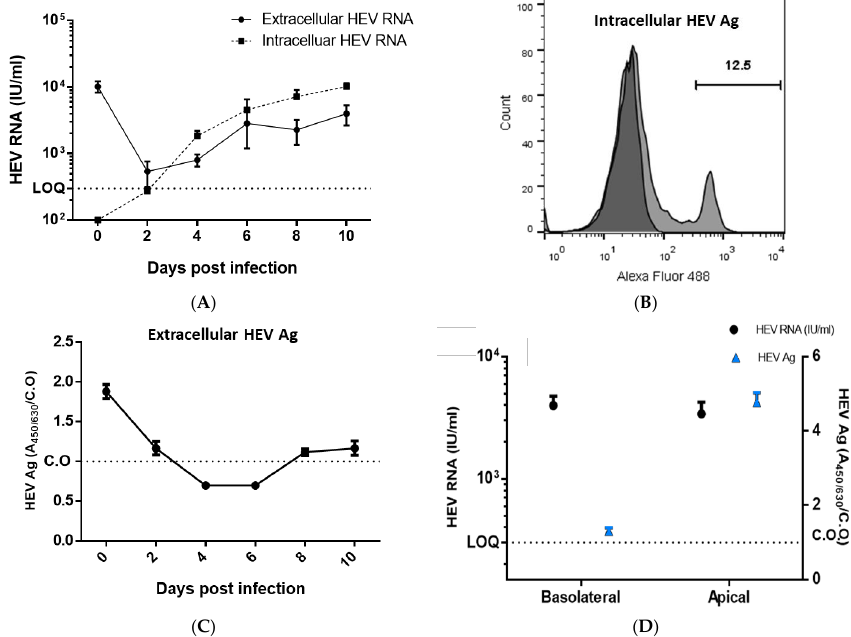
Figure 2. Infection of the CD10 + /CD13 + PT epithelial cells with HEV inoculum. ( A ) Infection of polarized CD10 + /CD13 + PT cells, cultured on transwell, with HEV-1 inoculum at the basolateral side. Intracellular (dotted line) and extracellular (solid line) HEV RNA was quantified by qPCR. LOQ: limit of quantification. Depicted are the mean values of three independent experiments ± SEM. ( B ) Representative gating strategy showing the expression of HEV ORF2 Ag in the PT cells infected with HEV. The dark histogram represents cells stained with the secondary A488 conjugated anti-mouse antibodies alone; the light shaded histogram represents cells stained by mouse anti-HEV-ORF2 followed by A488 conjugated anti-mouse antibody. ( C ) Supernatants collected from HEV-1 infected PT cells were tested for HEV ORF2 Ag by ELISA, C.O is the cutoff. Depicted are the mean values of three independent experiments ± SEM. ( D ) HEV RNA (black), and HEV Ag (blue) were measured at the basolateral and apical sides. Depicted are the mean values of three independent experiments ±